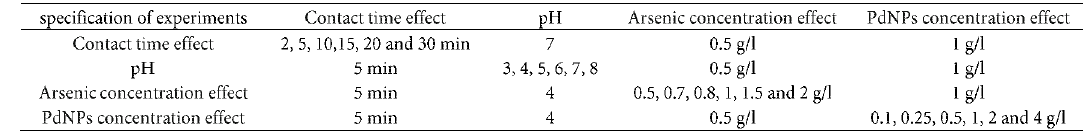
Table 1. Experimental design